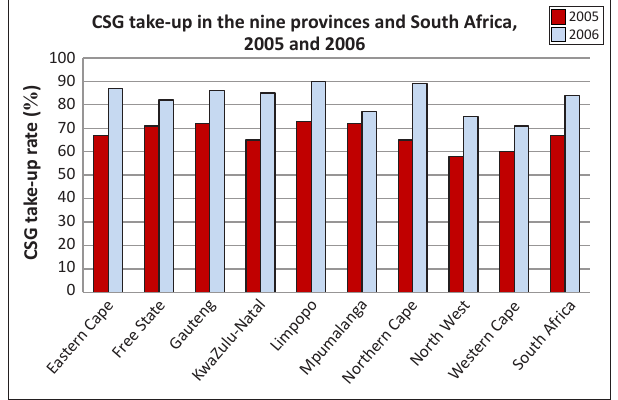
FIGURE 1: Example of a data representation requiring critical